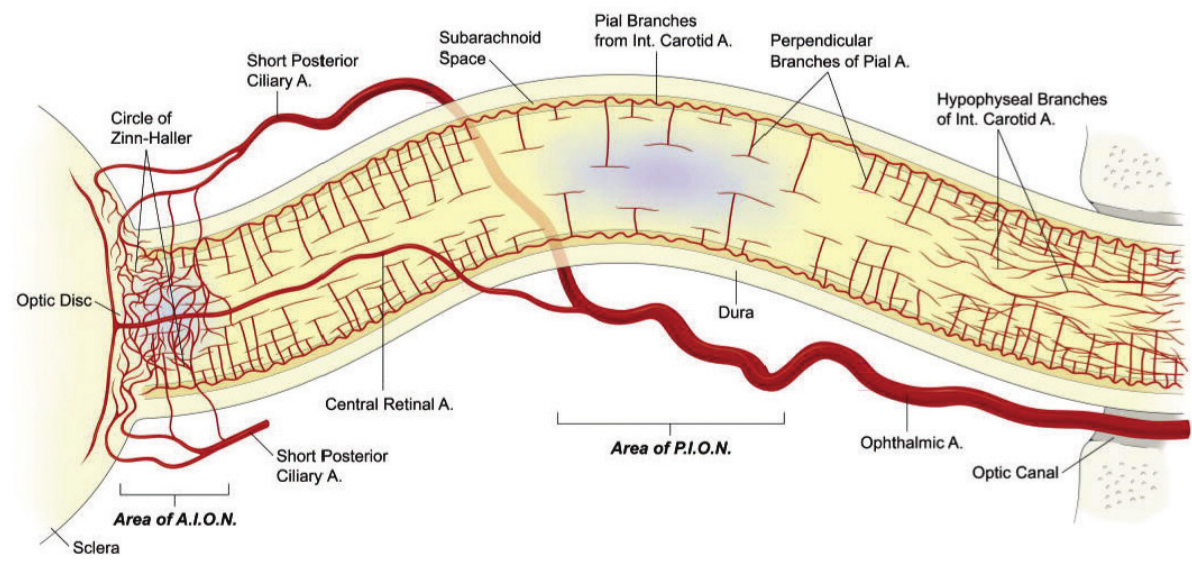
Figure 3. Diagram of the orbital optic nerve with its vascular supply. The areas involved in the ischemic insults are highlighted in purple. The anterior optic nerve is supplied by multiple sources while only the small pial branches supply the mid-orbital optic nerve. It is the mid-orbital region of the optic nerve that is involved in PION. The pial branches are found with variable density and in an unusual perpendicular T-shaped pattern, characteristic of a low pressure system. There is low density of arteriolar and capillary supply to this mid-orbital segment compared with the canalicular or retro-bulbar segments of the optic nerve. A., Artery; AION, Anterior Ischemic Optic Neuropathy; PION, Posterior Ischemic Optic Neuropathy. Image courtesy of Baig M.N. et al. , 2007, Vision loss after spine surgery: review of the literature and recommendations, Neurosurgical Focus , November, 23 (5): E15 6 . Re-print permission has been obtained from the Journal of Neurosurgery Publishing Group. This figure is not subject to the CC license that the rest of this paper is subject to. Any use of this figure is subject to obtaining the necessary permissions from the Journal of Neurosurgery Publishing